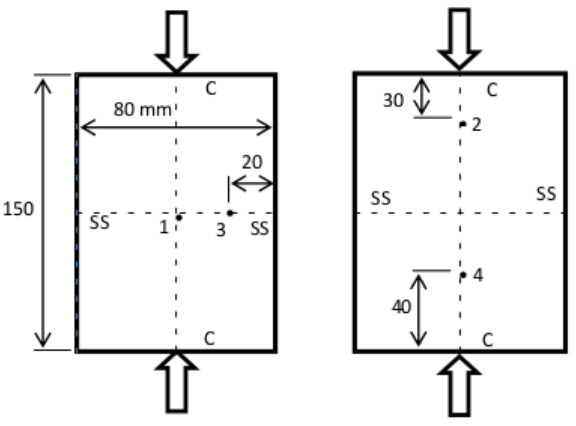
Figure 4: Schematic of buckling test set up showing the location of points where LVDTs are attached. Table 2: Dimensions of plate specimens in buckling